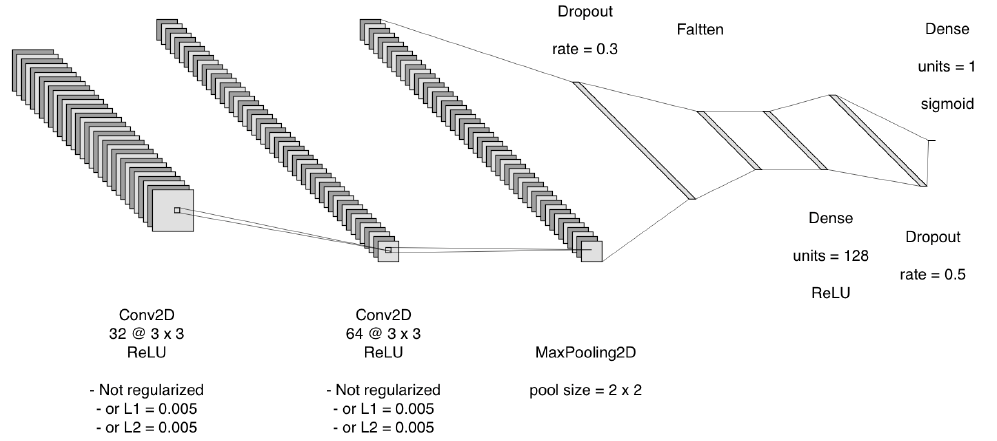
Figure 2. The layers architecture of the three CNN classifiers. Table 6. The selected hyperparameters to build the CNN